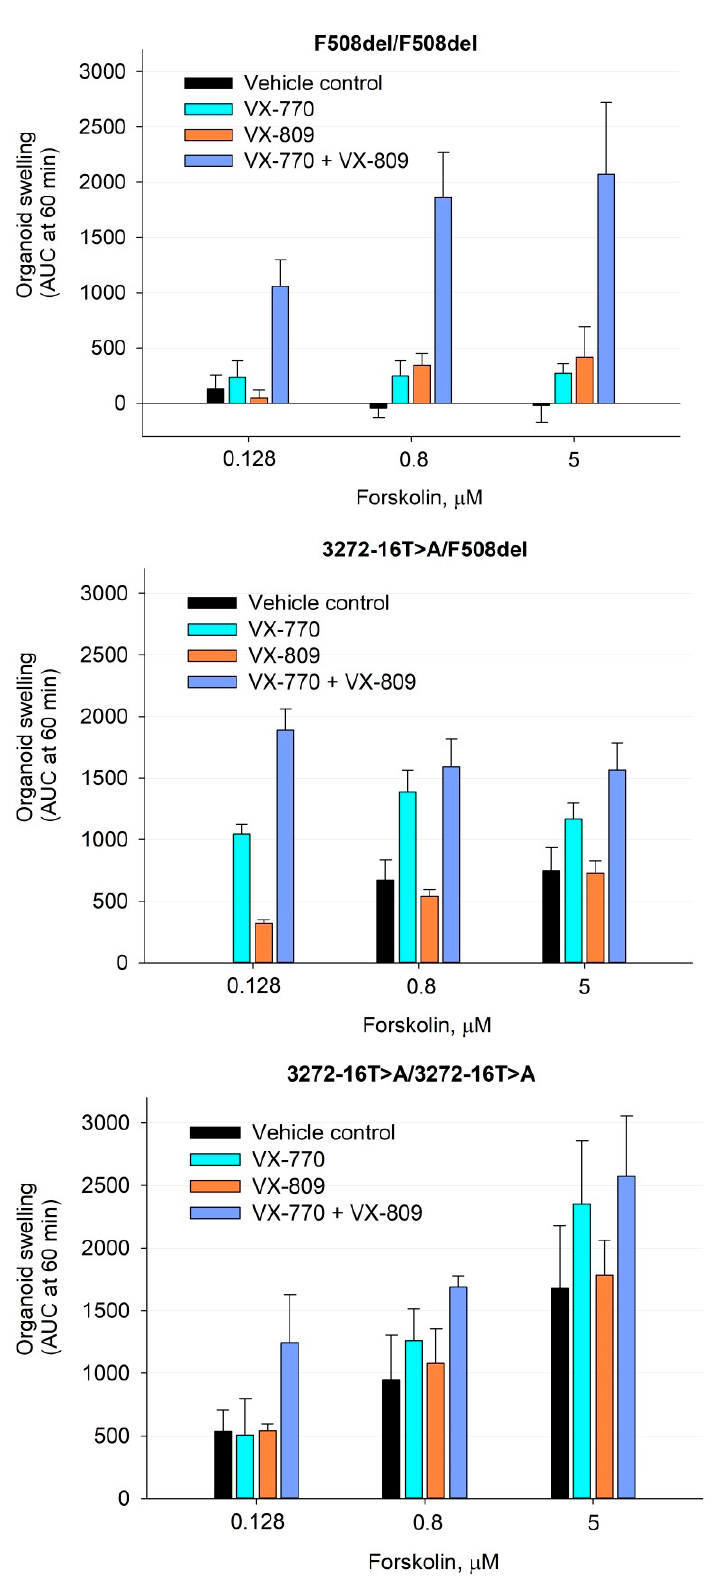
Figure 4. Results of quantitative assessment of organoid swelling under the action of forskolin and CFTR modulators for patients with the genetic variant c.3140-16T>A (3272-16T>A) and F508del/F508del control. Working concentrations-3.5 μ M for VX-770 and 3.5 μ M for VX-809. AUC, area under the curve.